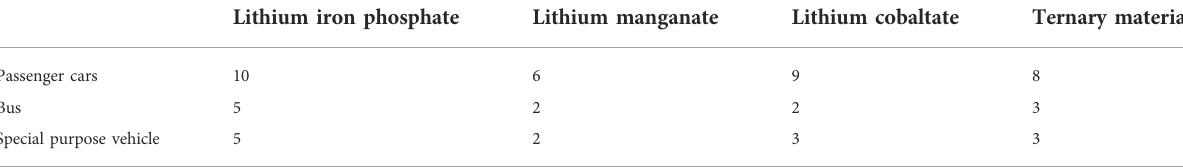
TABLE 2 Set values for the maximum years of retirement of new energy vehicles in China, 2014 –